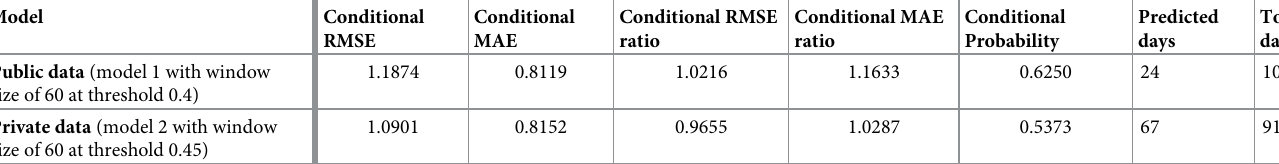
Table 5. Different performance evaluation measures for the best models of public and private data. Model Public data (model 1 with window size of 60 at threshold 0.4) Private data (model 2 with window size of 60 at threshold